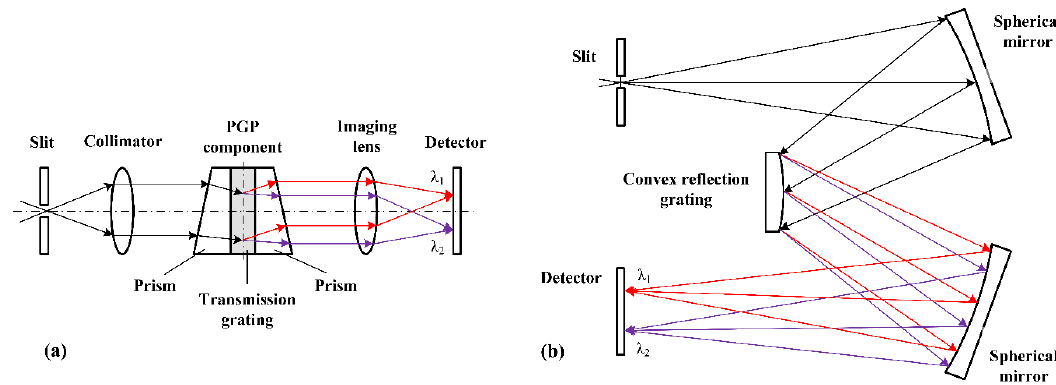
Figure 2. Diagrams of a transmission grating-based imaging spectrograph using a prism-grating-prism (PGP) component ( a ) and a reflection grating-based imaging spectrograph using an Offner configuration ( b ), where λ 1 and λ 2 represent different wavelengths.